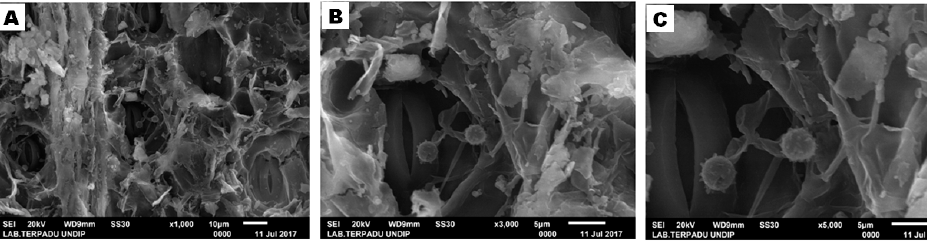
Figure 10. Result of SEM EDX of kenaf fiber with magnification of: ( A ). 1000x; ( B ). 3000x, and ( C ) 5000x.